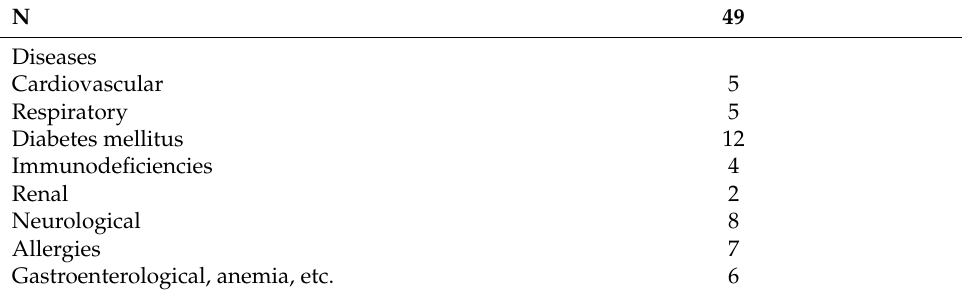
Table 2. Children’s